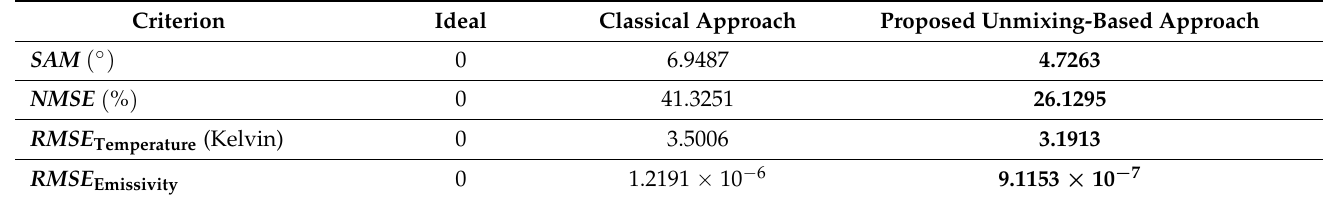
Table 2. Mean values of the SAM and NMSE criteria for the synthetic data and RMSE values of the estimated parameters (the bold values represent the best performances).